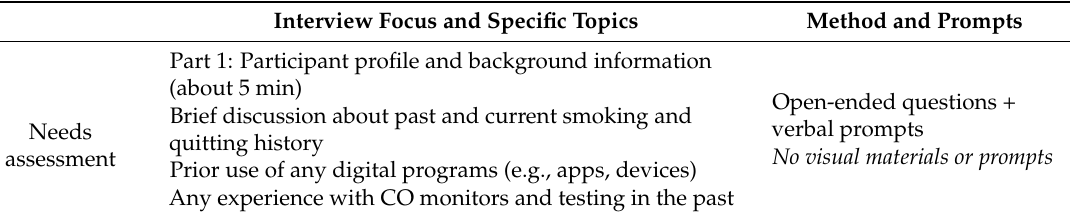
Table A1. Interview topics covered in 2016 and 2017